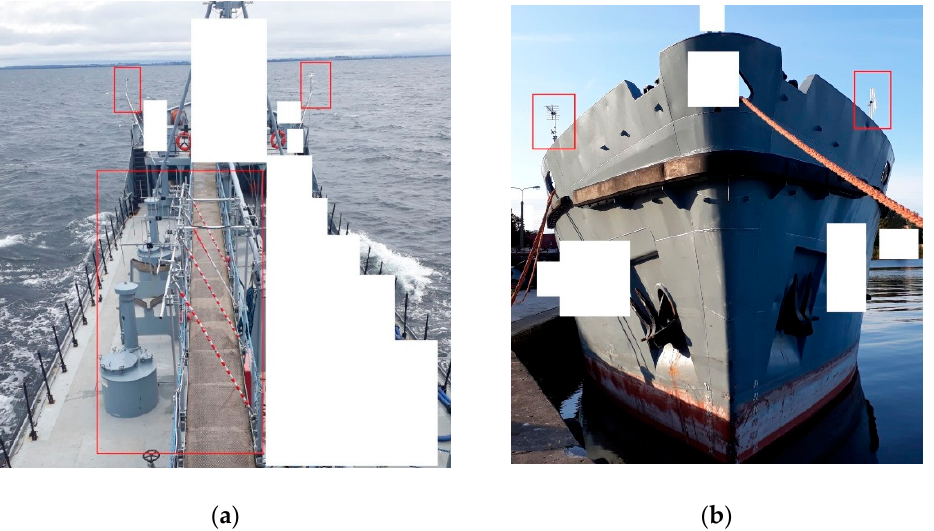
Figure 3. Top view of the antenna array ( a ) and additional reference antennas on front of ship ( b ) (some parts of the picture are masked for security and privacy reasons).